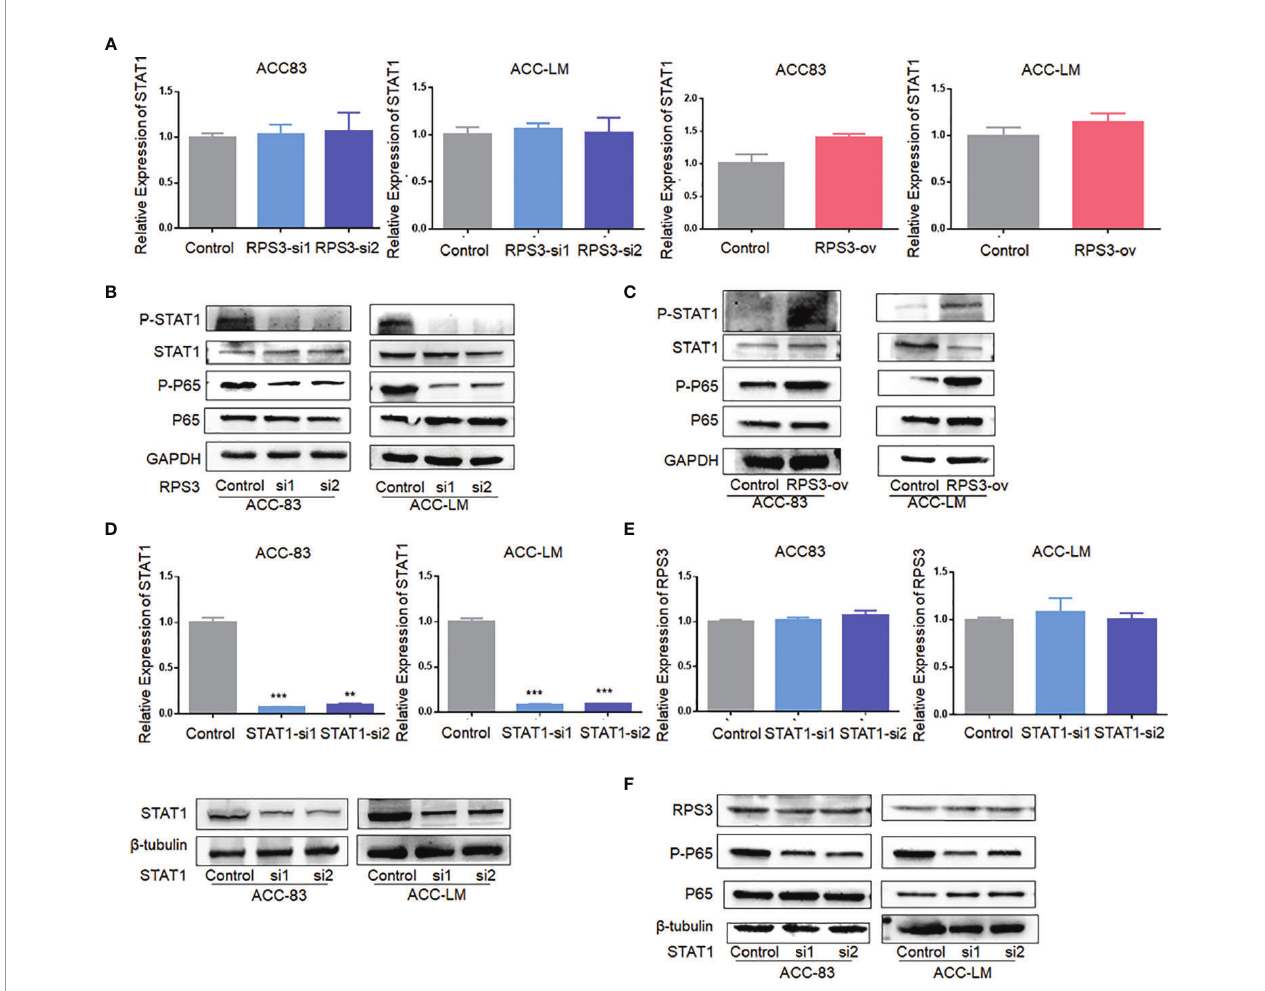
FIGURE 5 | RPS3 was involved in the regulation of the STAT1/NF-kB signaling pathway. (A) QPCR showed no signi fi cant change in STAT1 mRNA levels in ACC cells after changing the expression RPS3. (B) WB showed a signi fi cant decrease in STAT1 and P65 phosphorylation after RPS3 expression was reduced. (C) WB showed increase activation of STAT1 and P65 after RPS3 overexpression. (D) QPCR and WB experiments showed that the mRNA and protein levels of STAT1 were decreased after transfection with siRNA in ACC-83 and ACC-LM. (E) QPCR showed there was no change in mRNA levels of RPS3 after STAT1 expression was reduced. (F) WB showed that after STAT1 sxpression was redued, there was no change in the posttranscriptional level of RPS3, but P65 activation was reduced. **P < 0.01; ***P <